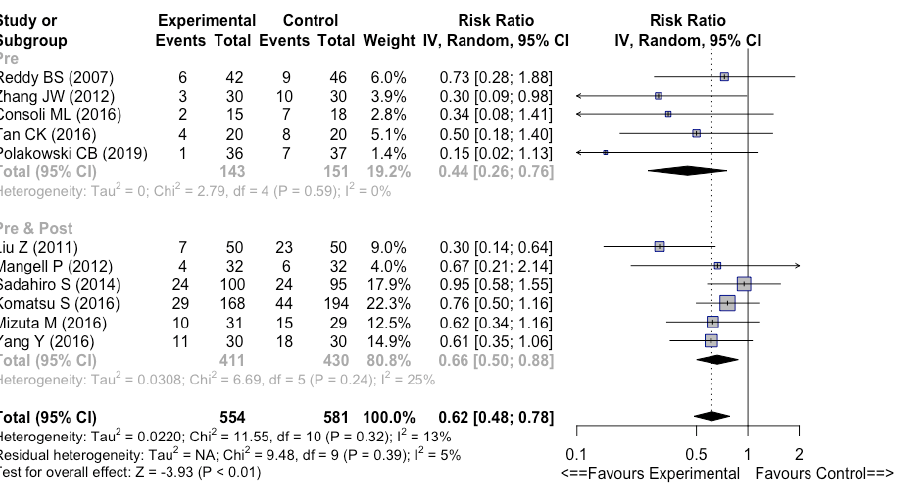
Figure 6. Forest plot of the timing of perioperative [26,27,31,34,35,37] versus preoperative [24,28,33,36,40] use of probiotics or synbiotics. Outcome = overall infectious complications.